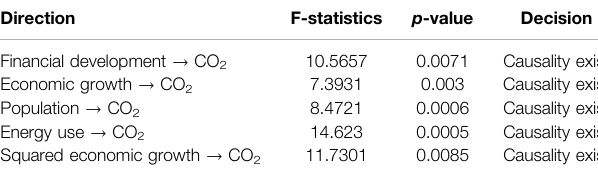
TABLE 8 | Short-run causality analysis.